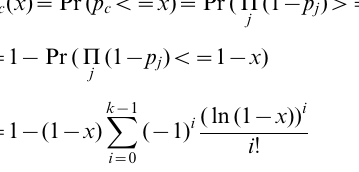
Figure S2 Comparison of different motif scanning methods.